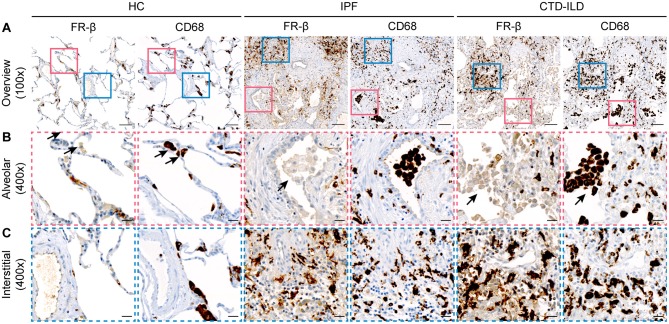
FR-β is mostly expressed in the lung interstitium in human ILD. Representative images of sequential lung sections from healthy controls (HC, n = 26) and patients with IPF (n = 39) and CTD-ILD (n = 14) that were stained with FR-β and the human macrophage marker CD68. (A) Overview images at 100× magnification are shown (scale bars: 100 μm). Colored squares indicate regions of interest for the higher magnification images depicted in (B,C). (B) Higher magnification images at 400× magnification (scale bars: 20 μm) indicating the only weak to undetectable expression of FR-β on macrophages located in alveolar spaces (arrows). (C) Higher magnification images at 400× magnification (scale bars: 20 μm) indicating the strong expression of FR-β on macrophages located in the lung interstitium.